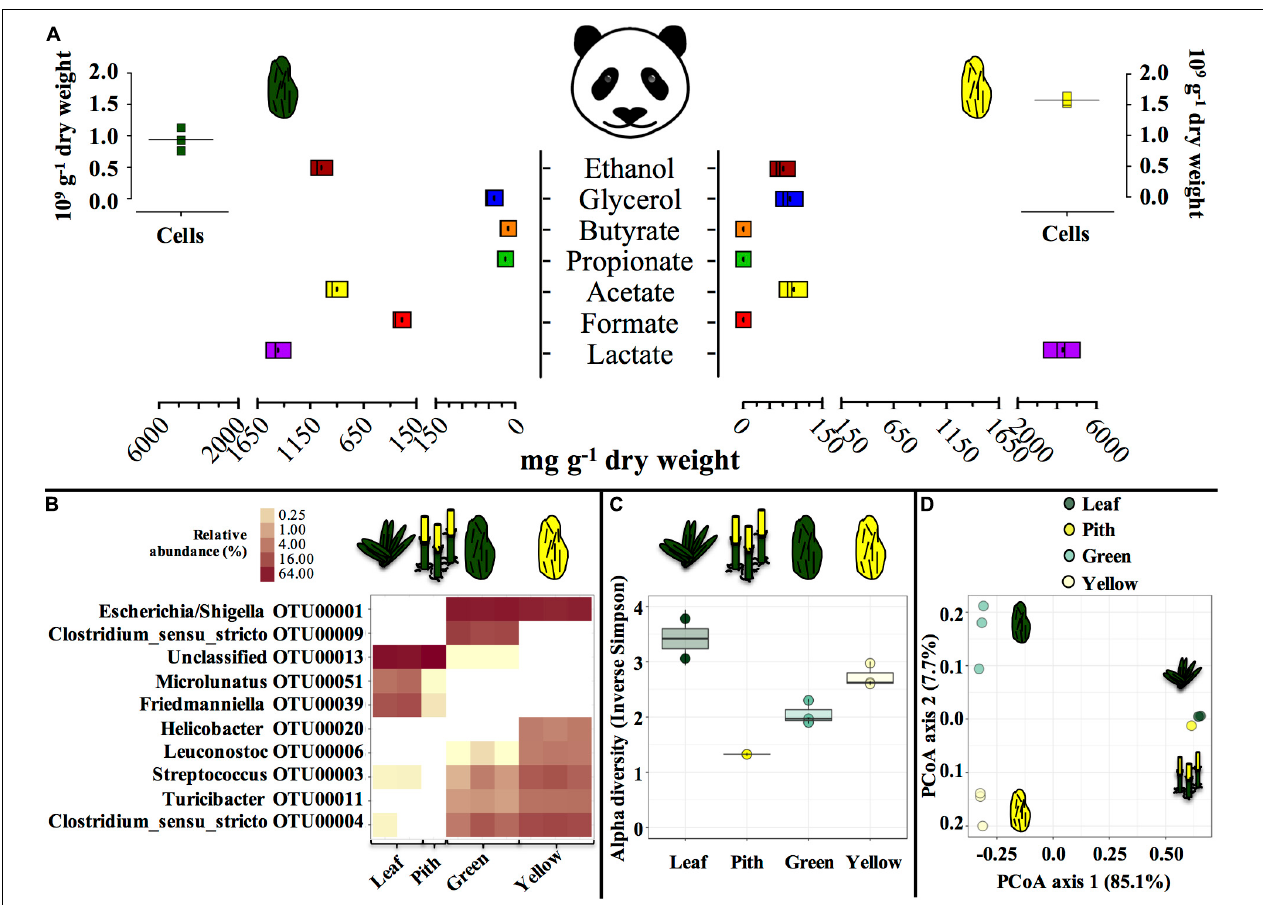
FIGURE 1 | Microbial and biochemical characterization of giant panda fecal matter (A–D) and microbial community composition (B–D) in P. bisettii bamboo fed to the giant panda in the present study. In (A) , squares of the same color represent each a single replicate ( n = 3), with black dots or lines indicating the mean. In (B–D) , each single replicate is reported. For plant material (leaf and pith), DNA extraction was conducted on two samples each, however, DNA from one pith sample could not be amplified, therefore the pith is represented by a single sample. Green and yellow dung samples were tested in triplicate ( n = 3). In (B) the top 10 most abundant OTUs across all samples were selected (all data in Supplementary Table S2 ). In particular, (C) reports the Alpha diversity (Hill order 2, Inverse Simpson index) of the microbial community in giant panda fecal matter; circles indicate each single replicate ( n = 3), whiskers indicate min to max values, and black lines the mean average. In (D) the beta diversity analysis by means of principal coordinate analysis (PCoA) of the microbial community in giant panda fecal matter is reported. A 3% dissimilarity threshold was used to define